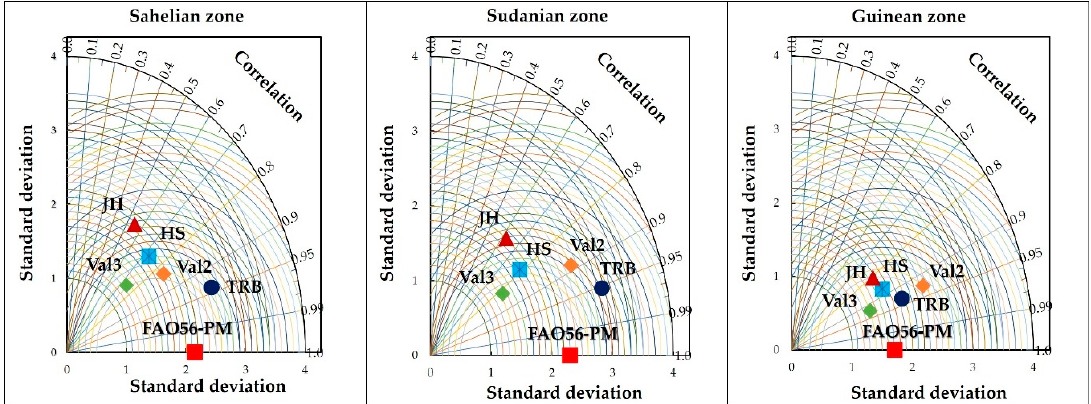
Figure 6. Taylor's diagram of the best methods over the validation period according to climatic zones.